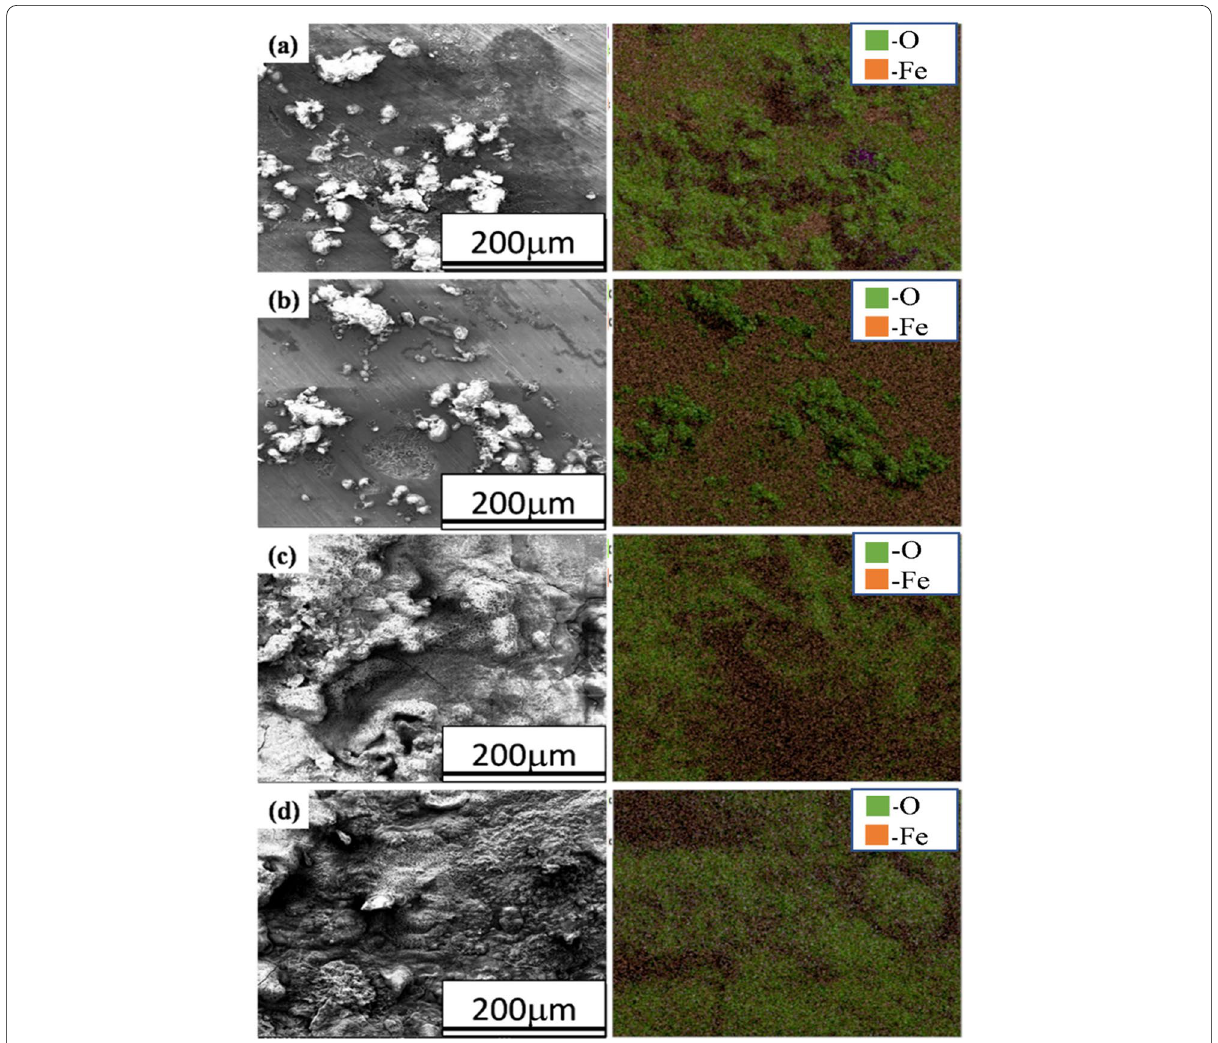
Fig. 12 SEM-EDS elemental maps of corroded surface of a annealed, b normalized, c quenched, and d austempered AISI 1050 steel specimens after electrochemical testing in 3.5% NaCl solution